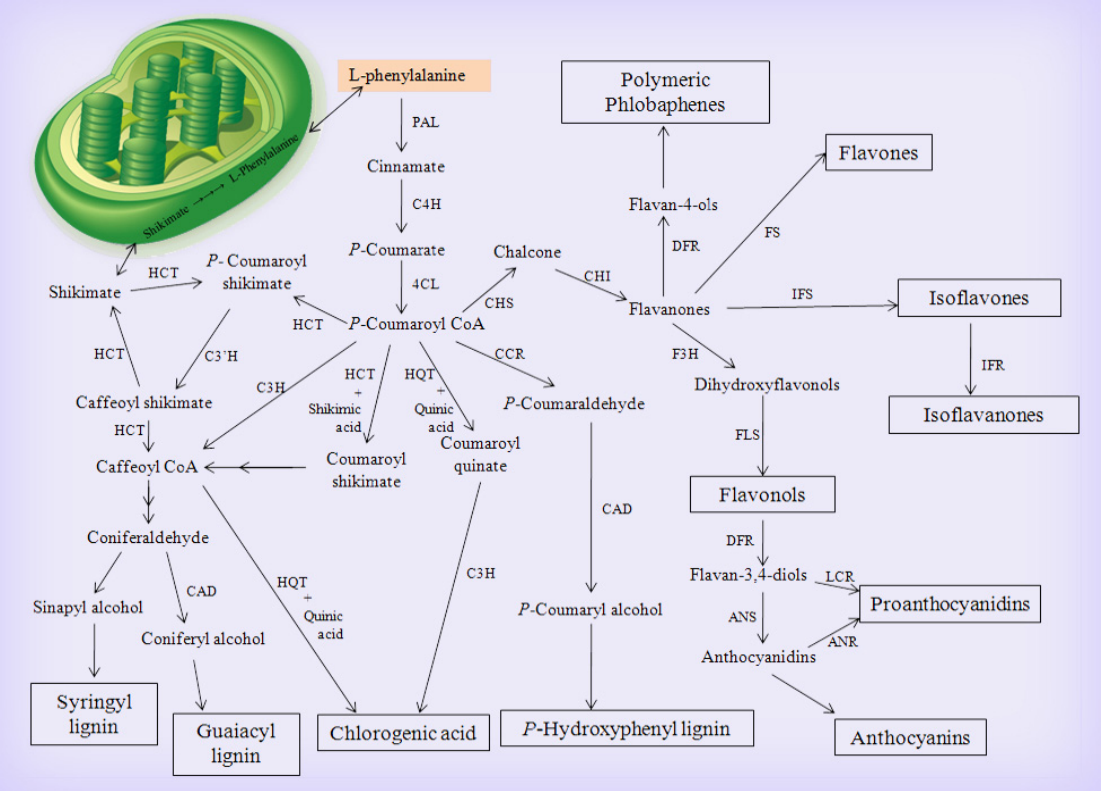
Figure 1. Graphical diagram of the polyphenol biosynthetic pathway (adapted from André et al. [20],